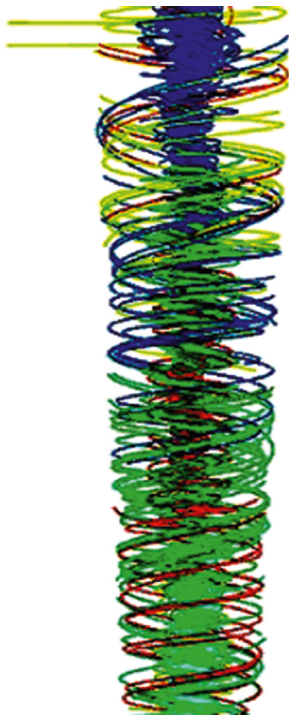
Figure 6: Streamlines of the continuous phase (water).